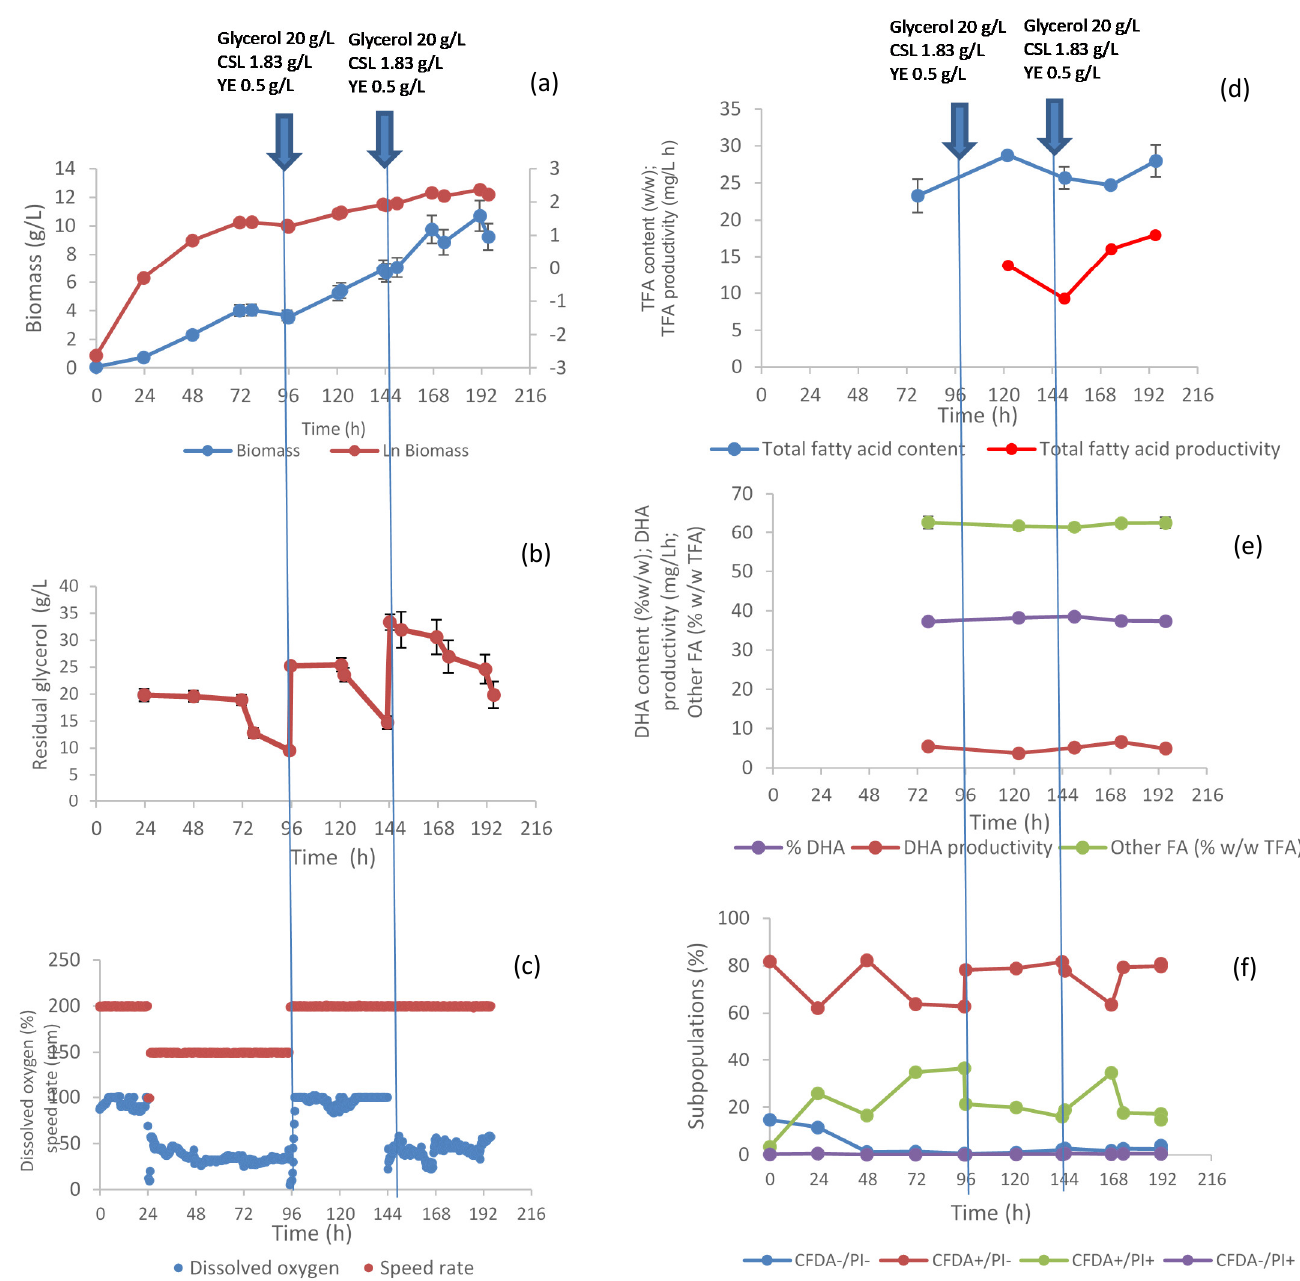
Figure 2. C. cohnii profiles during a fed-batch fermentation in a 7L bioreactor. ( a ) Biomass concentration and natural logarithmic; ( b ) Residual glycerol concentration; ( c ) DO and speed rate; ( d ) TFA content and productivity; ( e ) DHA content, DHA productivity and other fatty acids percentage; ( f ) C. cohnii subpopulation cells stained with CFDA and PI and analyzed by FC. Subpopulation CFDA+/PI− included cells with intact membranes with enzymatic activity; Subpopulation CFDA+/PI+ included cells with injured membranes and enzymatic activity; Subpopulation CFDA−/PI+ included cells with injured membranes and no enzymatic activity. Biomass, residual glycerol concentrations, TFA and DHA content values are the average value of two independent replicates with a standard deviation ( n = 2) represented as error bars. Biomass productivity (g/L h) was calculated as follows: X t − X 0 /(t t − t 0 ), where X t is the biomass concentration at the instant t , X 0 is the biomass concentration at t 0 (inoculation time); the same formula was used to calculate TFA and DHA productivities.